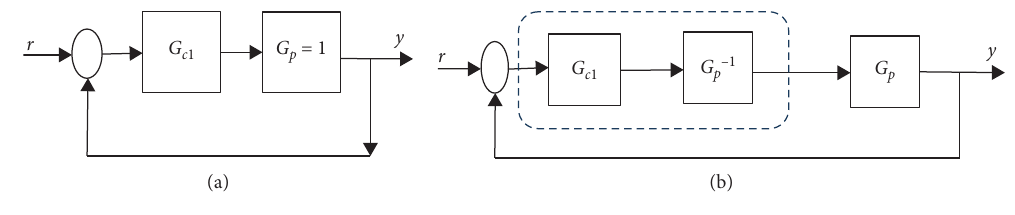
Figure 3: Model-independent control system